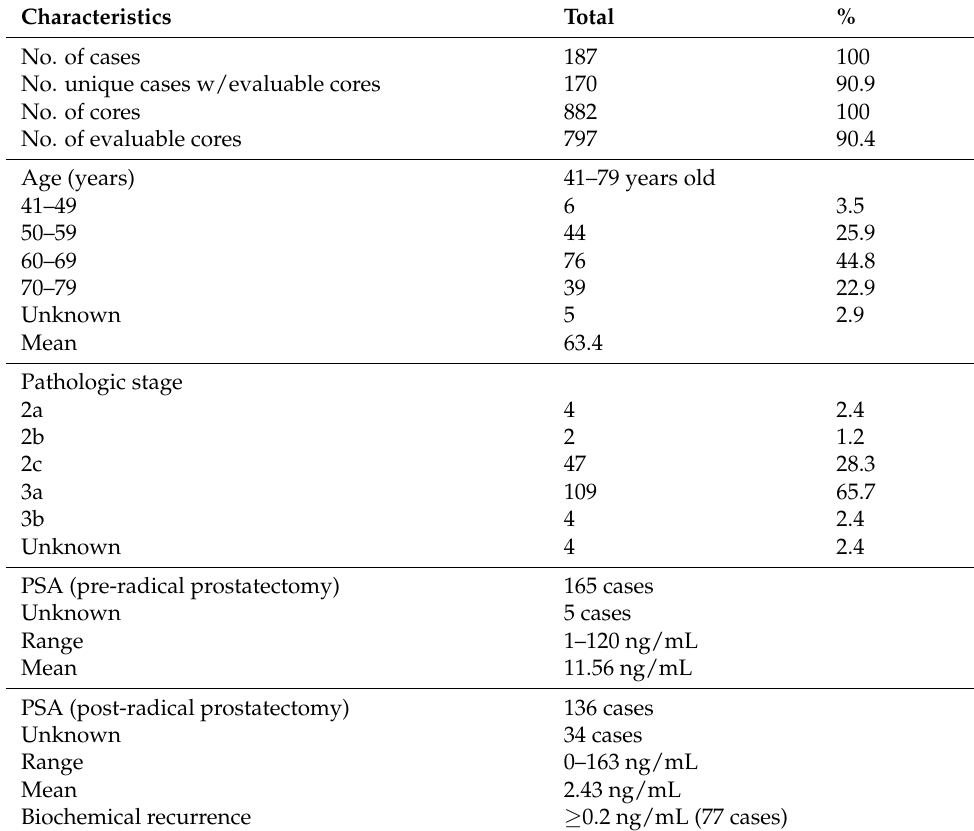
Table 1. Characteristics of the arrayed prostate cancer tumors and clinical data.